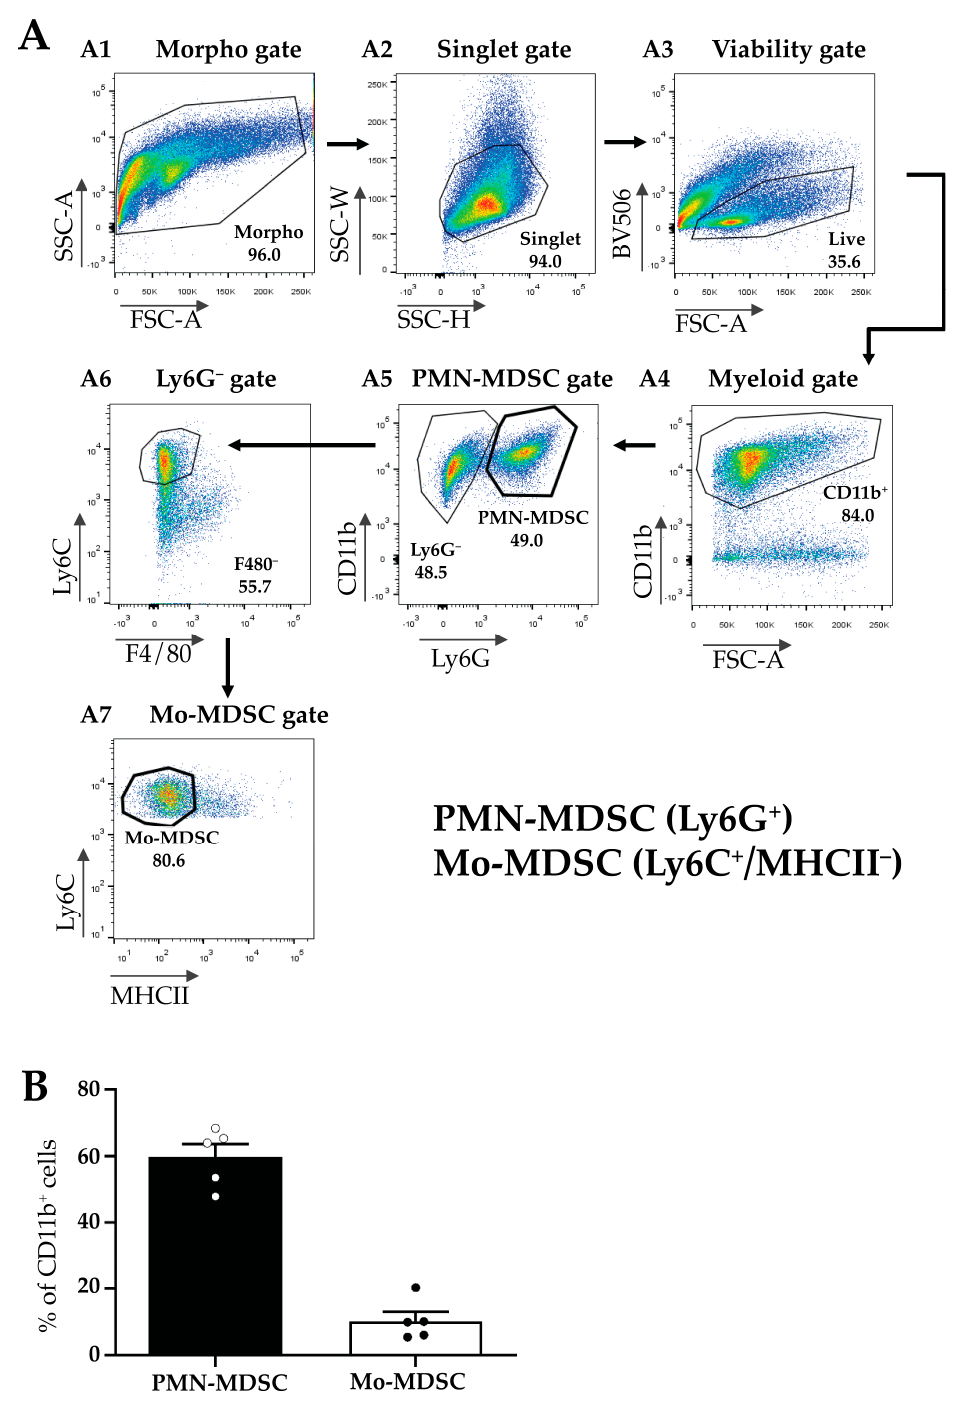
Figure 2. Flow cytometric characterization of the myeloid cellular populations in LLC tumors. ( A ) Gating strategy for the identification and sorting of myeloid subsets such as Mo-MDSCs and PMN- MDSCs from the TME. Panels show representative flow cytometric plots of the sorting of MDSC subsets. Following the application of the morphological gates (( A1 ) Morpho gate and ( A2 ) Singlet gate) viable cells were sorted based on the Fixable Viability Dye eFluor 506 exclusion (( A3 ) Viability gate, BV 506). Myeloid cells were defined by their CD11b expression (( A4 ) Myeloid gate) and subsequently, distinguished into two subsets by Ly6G staining. Ly6G + cells were sorted as PMN- MDSCs (( A5 ) PMN-MDSC gate). Then, the Ly6G − population was examined for the expression of F4/80 macrophage-specific marker (( A6 ) Ly6G − gate). Ly6C + /F4/80 − cells were thereafter tested for